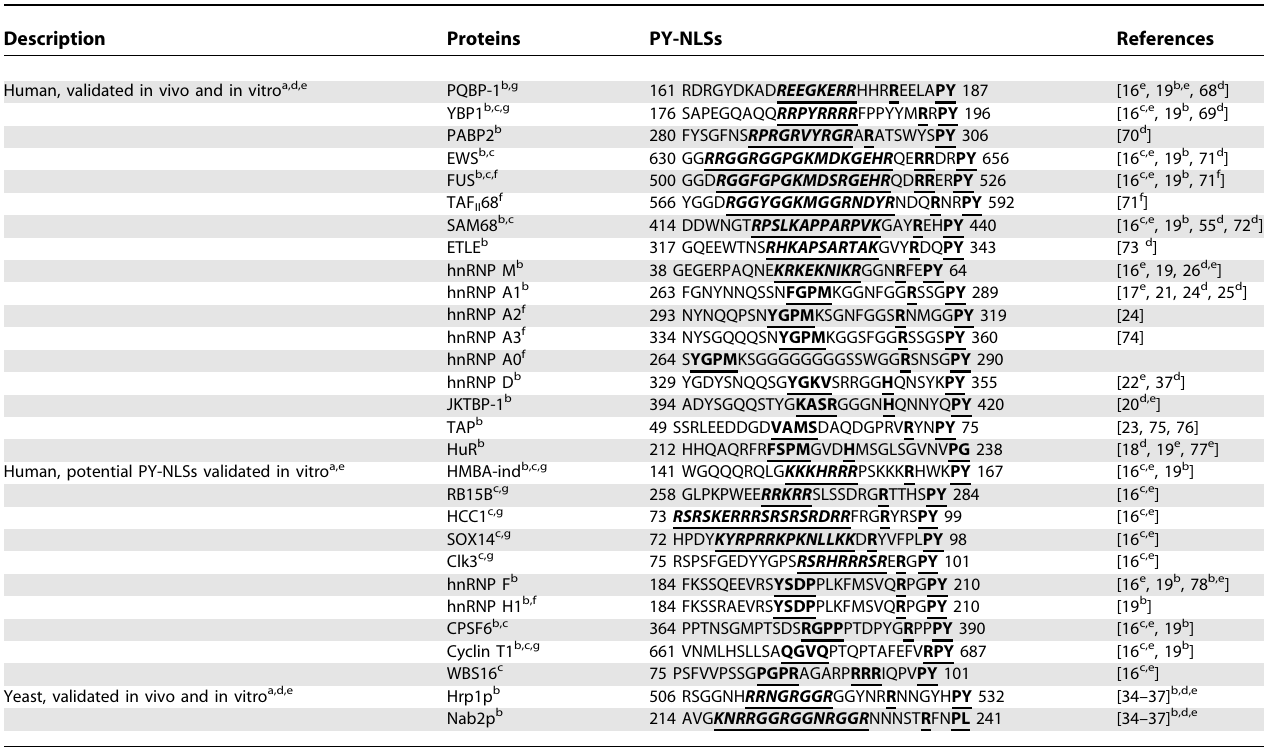
Table 1. Summary of Validated and Potential PY-NLSs